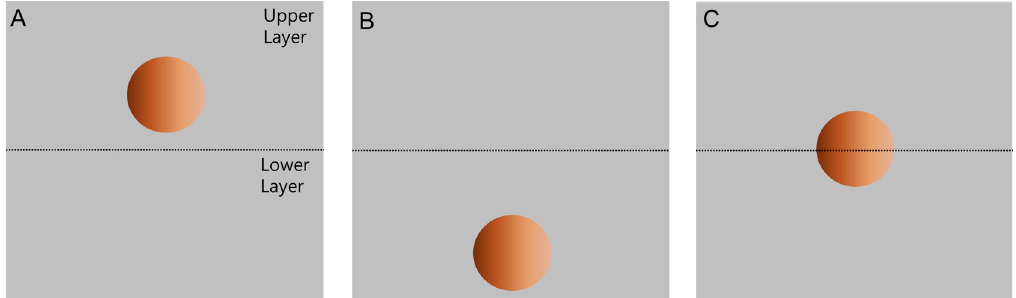
Figure 4. Distribution of microparticles in PEG-DEX ATPS. ( A ) microparticle that prefers the upper PEG-rich layer; ( B ) microparticle that is partitioned in the DEX-rich lower layer; ( C ) the microparticle that locates at the interface between two layers. The pictures are drawn conceptually and not to scale.